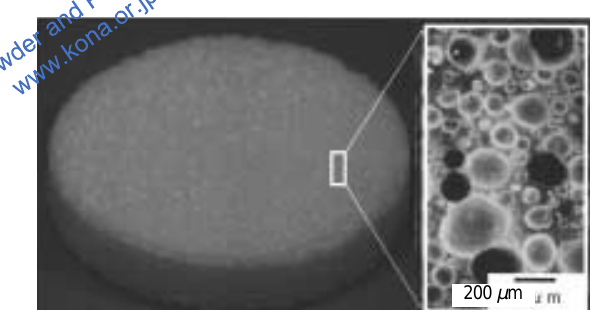
Fig. 14 Porous ceramics prepared by in situ solidification form- ing technique.